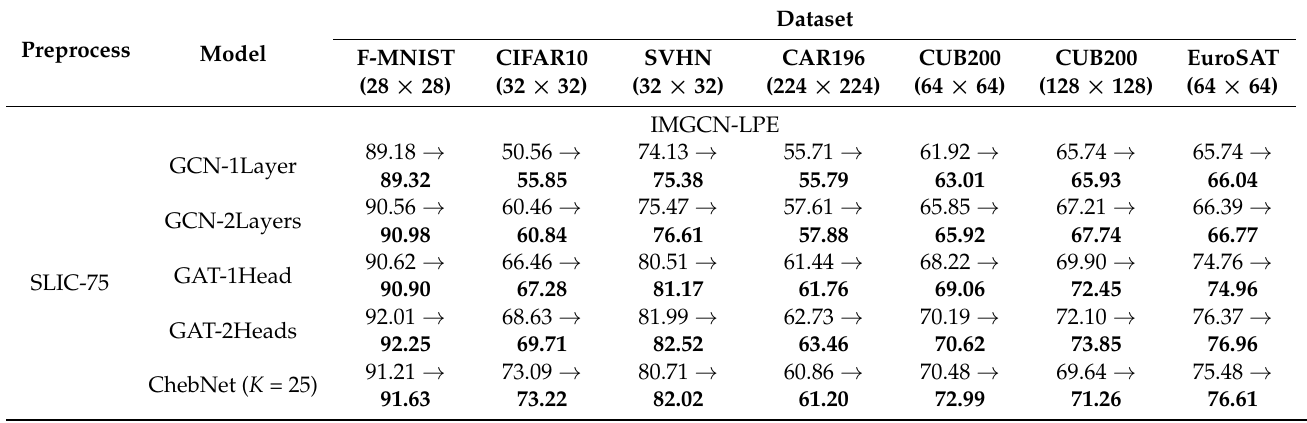
Table 3. Experimental results of ChebNet, GCN, and GAT after adding the ArcFace loss function with a weight of